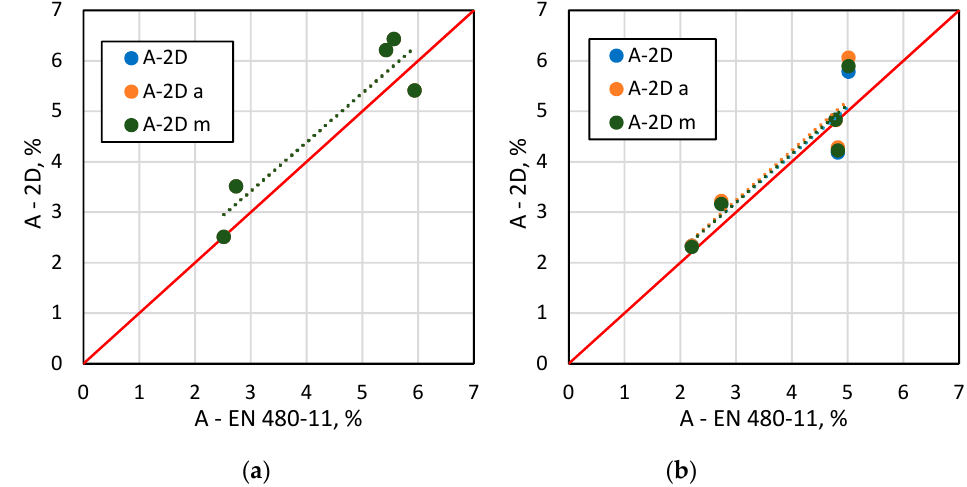
Figure 7. A comparison of EN 480-11 data versus the 2D analysis results for L : ( a ) equivalent diameter based 2D analysis; ( b ) perimeter based 2D analysis.